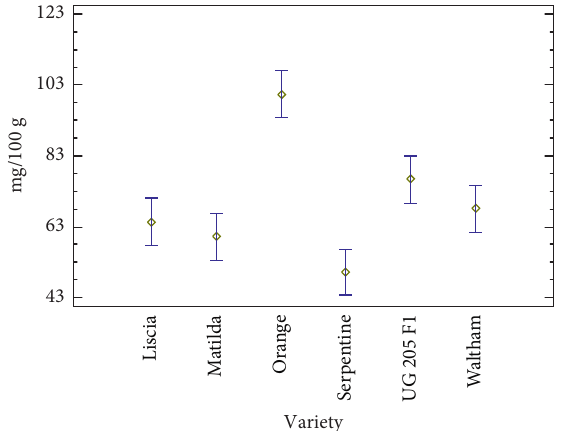
Figure 2: Intervarietal differences in total carotenoids content between the selected Cucurbita moschata Duch. varieties in dry matter (average of 2018 and 2019).